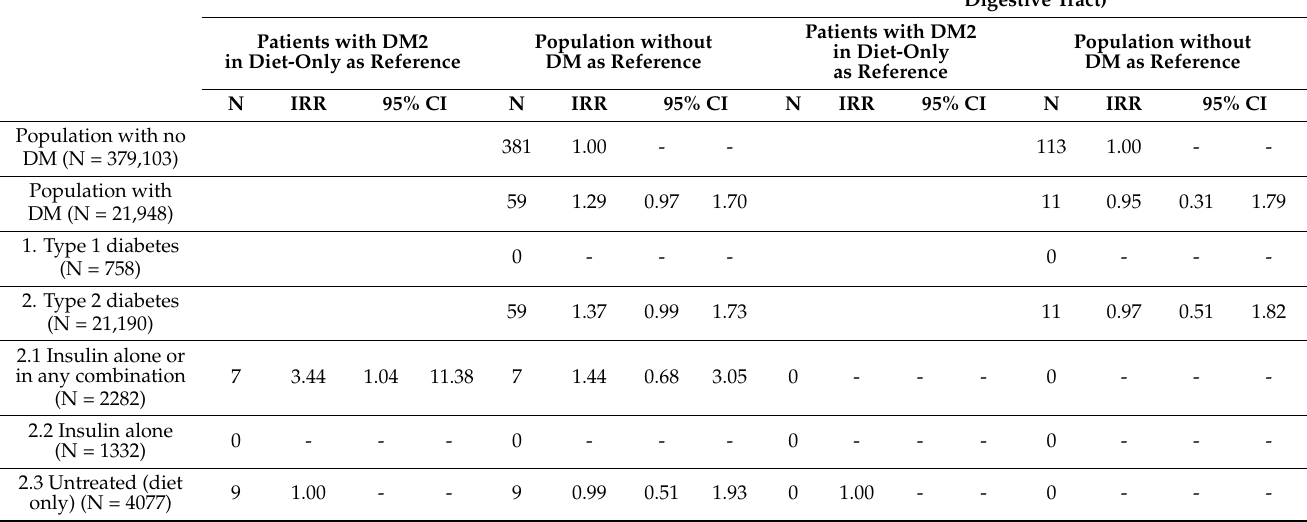
Table 7. Number, incidence rates ratios (IRR), and 95% confidence intervals (95% CI) of neuroen- docrine cancer, all sites and only from pancreas and digestive tract, by type of treatment with type 1 and type 2 diabetes (DM1; DM2), aged 20–84 years. See Supplementary Material Tables S5 and S6 for “neuroendocrine tumours in other sites” and Supplementary Table S7 site and morphology code selection